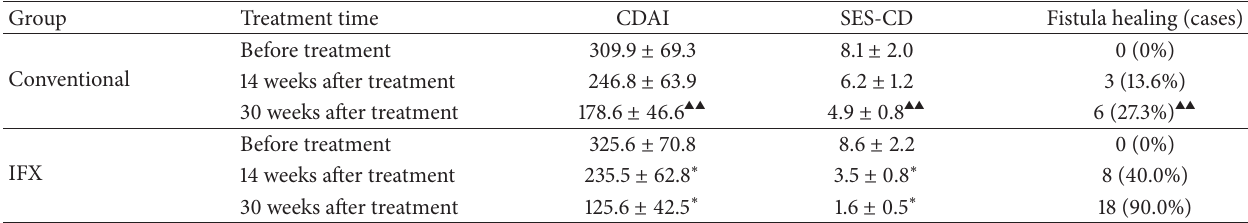
Table 3: Comparison of CDAI, SES-CD, and fistula healing before and after treatment in all cases. Group